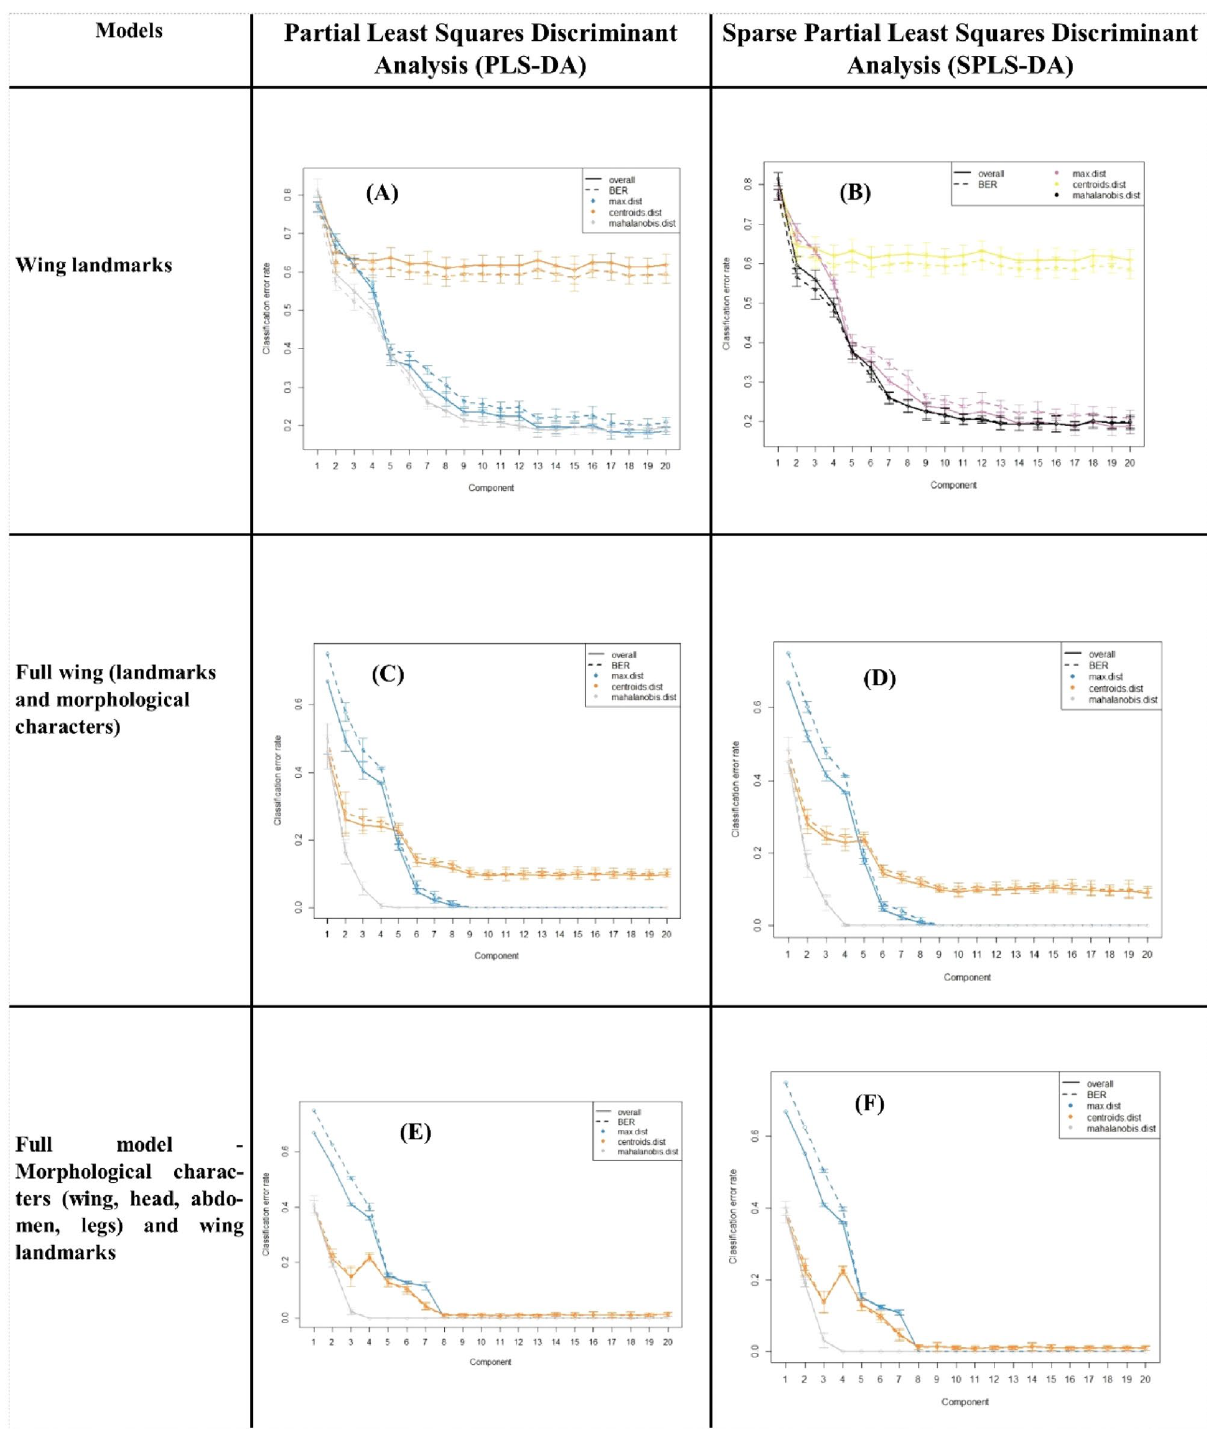
Figure 4. Balanced error rate (BER) choosing the number of dimensions. Performance and ncomp